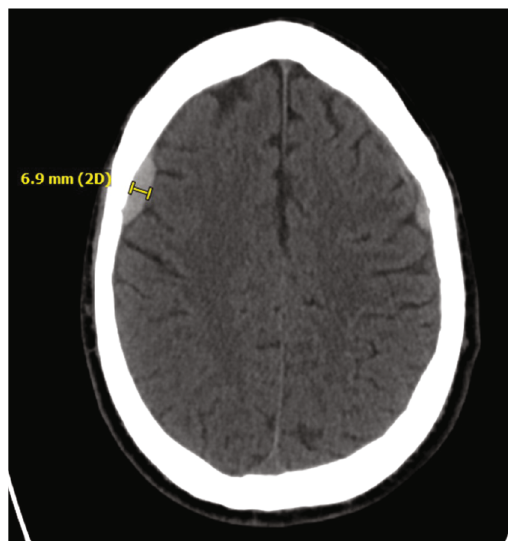
Figure 7: CT of left SDH at time of presentation in the emergency department.